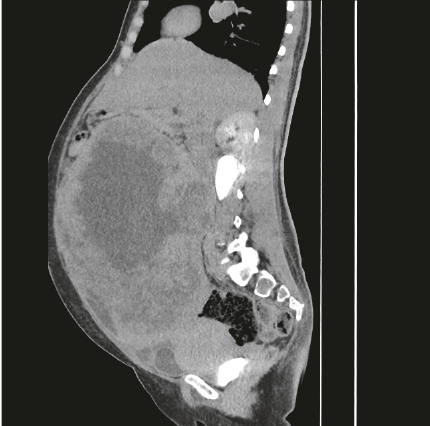
Figure 1: Presurgical evaluation showing the sagital slice of the abdominopelvic CT scan.